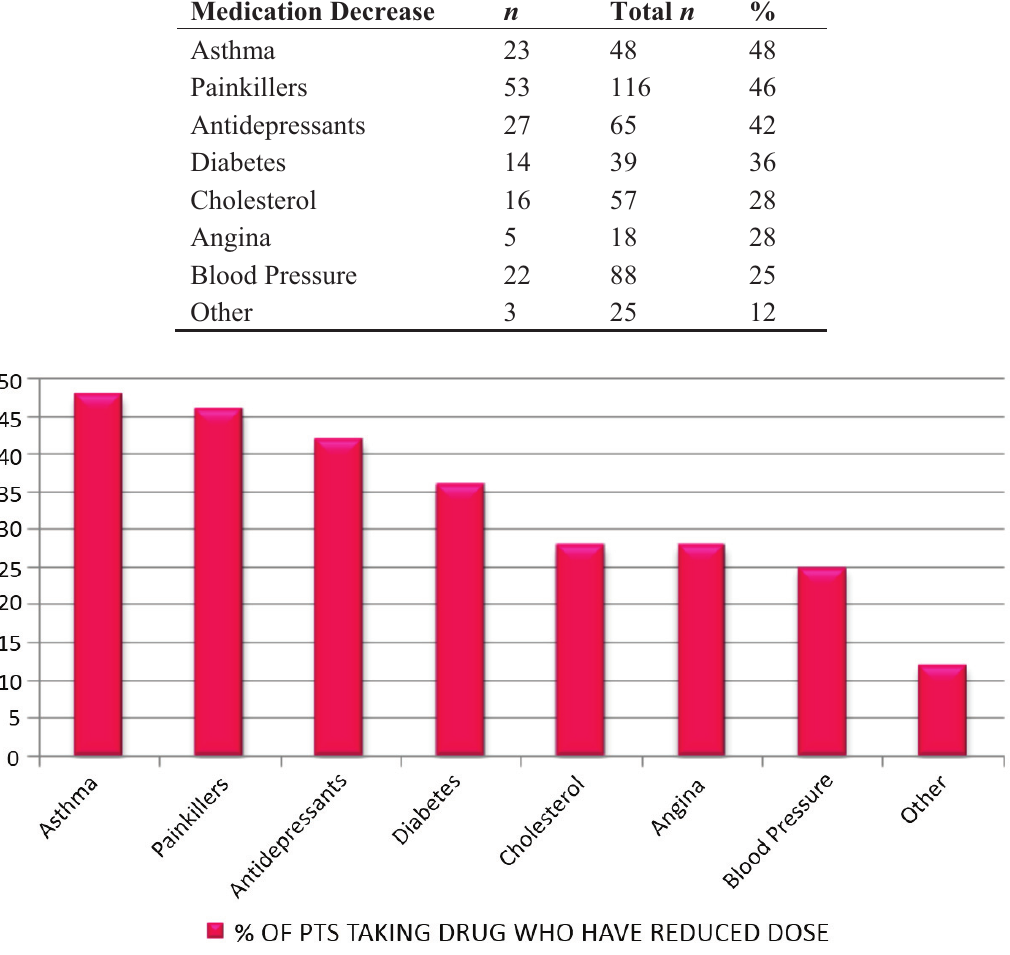
Figure 7. Percentage of patients taking obesity-related drugs who have reduced dose.